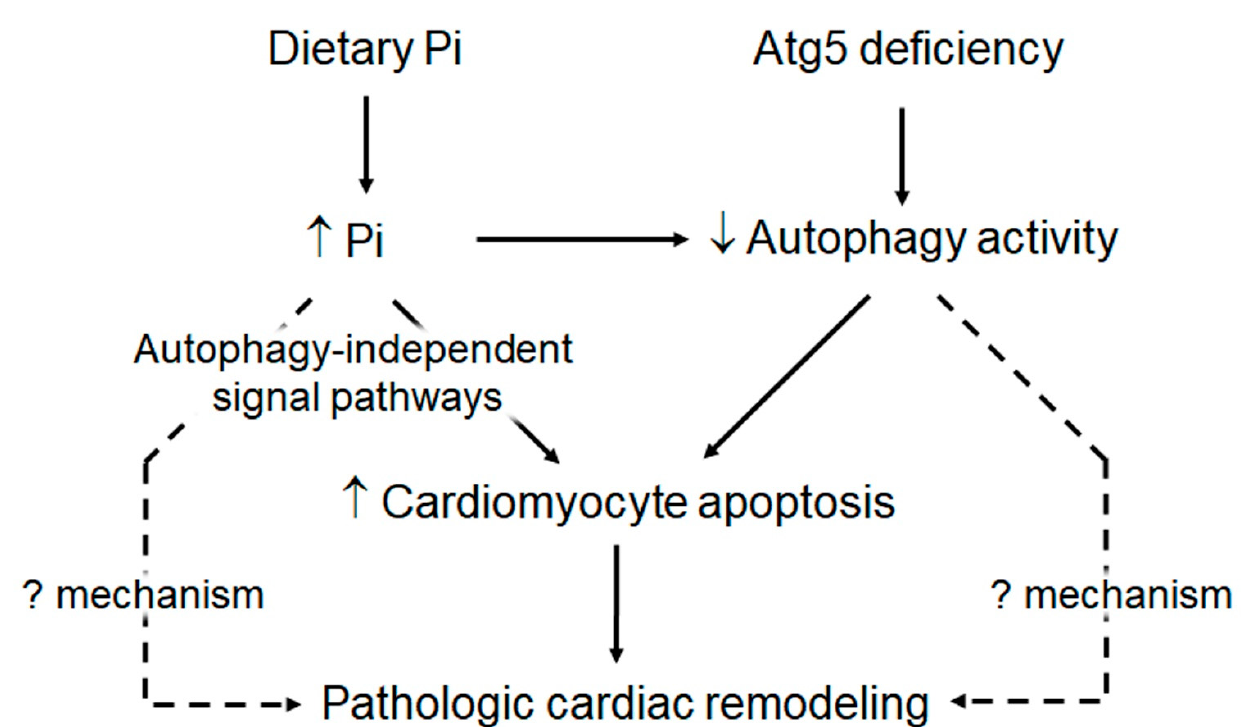
Figure 7. High phosphate exacerbates atg5 deficiency-induced cardiac remodeling. High phosphate decreases autophagy activity in cardiomyocytes. Atg5 deletion in cardiomyocytes downregulates autophagy activity in cardiomyocytes. Low autophagy activity results in cardiomyocyte apoptosis. High phosphate also induces cardiomyocyte apoptosis, which is autophagy-independent. Increase in apoptosis in cardiomyocytes leads to cardiomyocyte damage and cardiac hypertrophy and fibrosis. Therefore, high phosphate and low autophagy individually trigger and additionally promote heart deterioration. However, high-phosphate-induced pathologic cardiac remodeling might be autophagy-independent and apoptosis-independent (dash line), whose mechanisms are not explored in the current study. On the other hand, low autophagy can induce cardiac remodeling independently of apoptosis (dash line), which is worth illustrating.